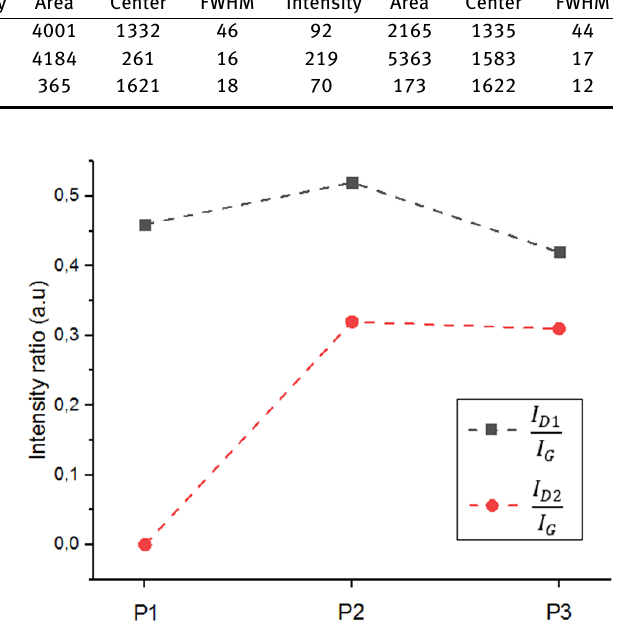
Table 2: Fitting parameters of the G, D1, and D2, bands for the NFG with different particles size. Band Line P1 Shape